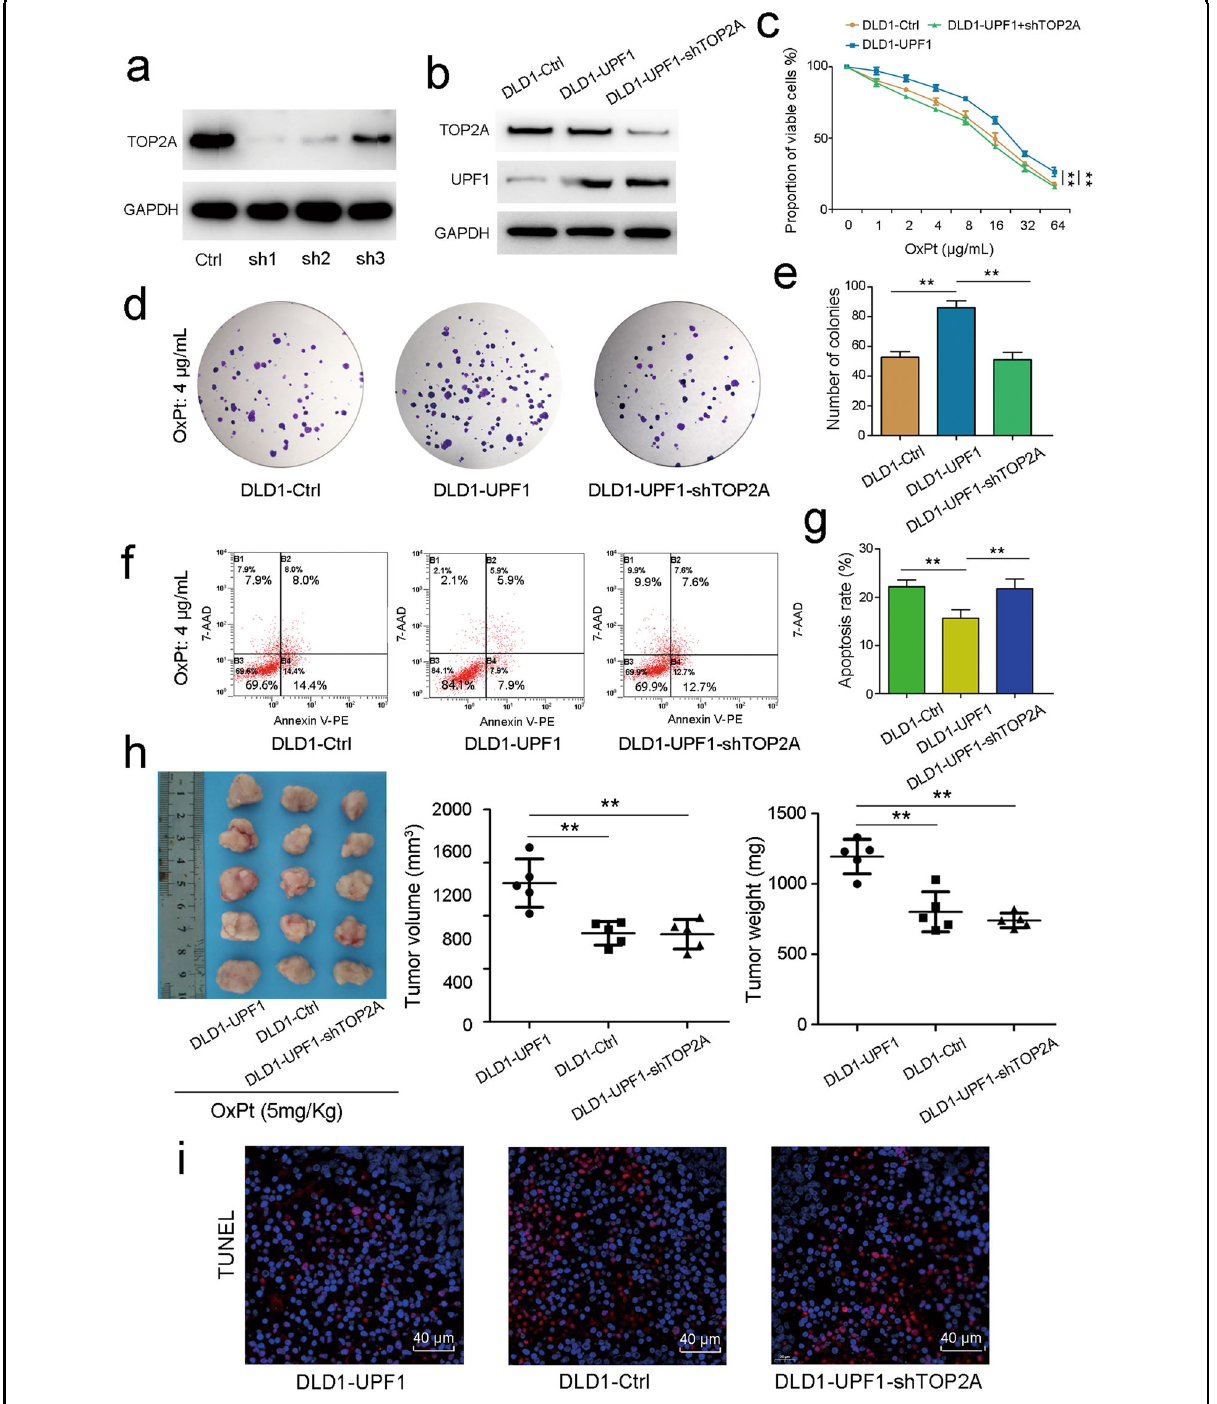
Fig. 6 UPF1-induced oxaliplatin resistance was abolished by silencing the TOP2A gene in vitro and in vivo. a , b TOP2A was silenced using small hairpin RNAs. c Drug cytotoxicity assay, d , e clone formation assay, and f , g fl ow cytometry showed abrogation of chemoresistance to oxaliplatin induced by UPF1 by knockdown of TOP2A. h Xenografts of DLD1-UPF1, DLD1-Ctrl, and DLD1-UPF1-shTOP2A treated with oxaliplatin and tumor volume and weight of xenografts in different groups. i TUNEL assay was performed to detect tumor cell apoptosis in xenograft tumor tissues, scale bar, 40 μ